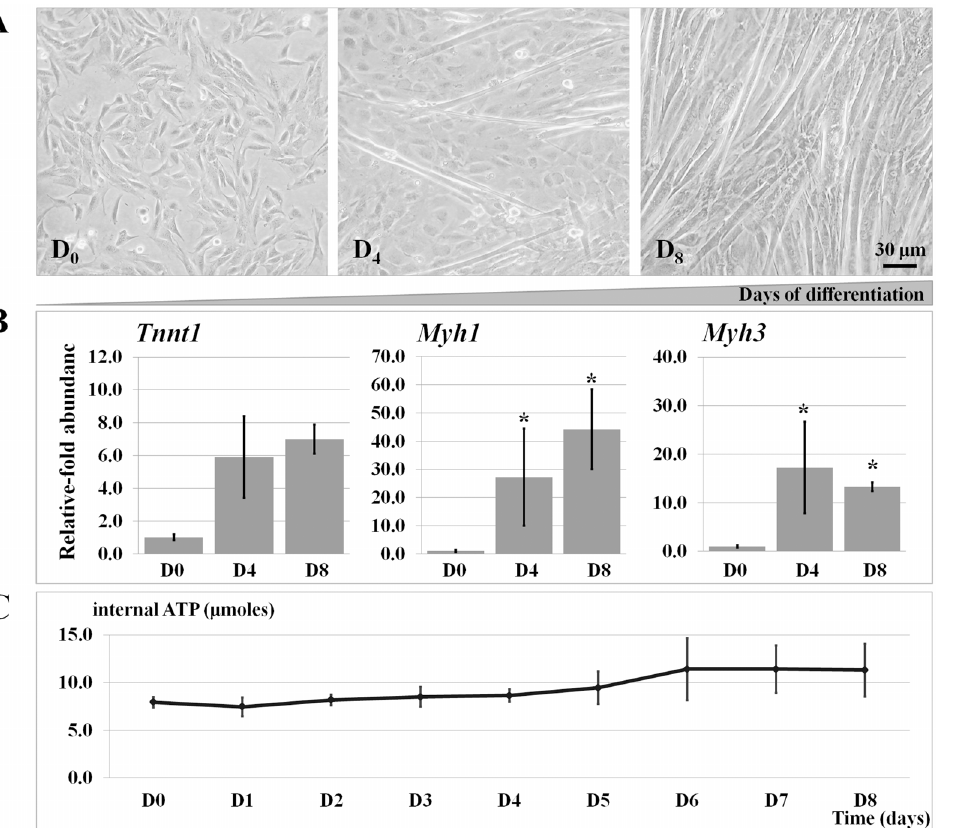
Fig 2. Characteristics of myogenic differentiation. (A) Morphological change of C2C12 myoblasts differentiating into myotubes at the post-induction D0 (undifferentiated mononucleated cells), D4 (elongated confluent cells), and D8 (long multinucleated myotubes). (B) Myogenic differentiation was accompanied by the up-regulation of Tnnt1, Myh1, and Myh3. (C) An increase in intracellular ATP level ( μ moles) during the course of myogenic differentiation. The ATP level is shown as mean ± SEM (n =